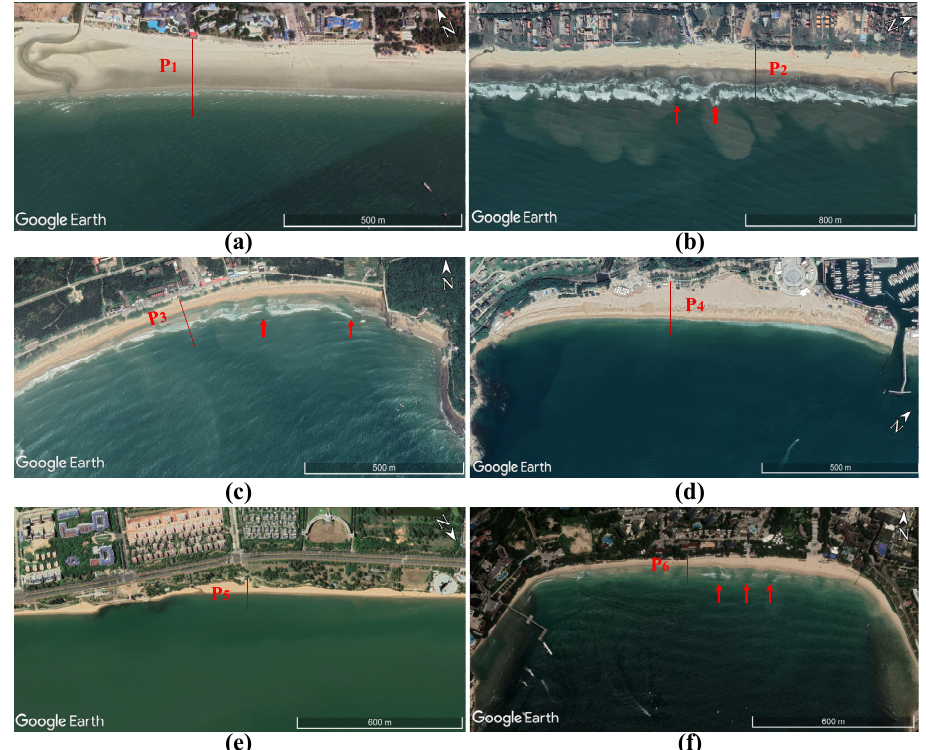
Figure 4. Monthly rip current hazards rating for six beaches based on morphodynamic analysis.